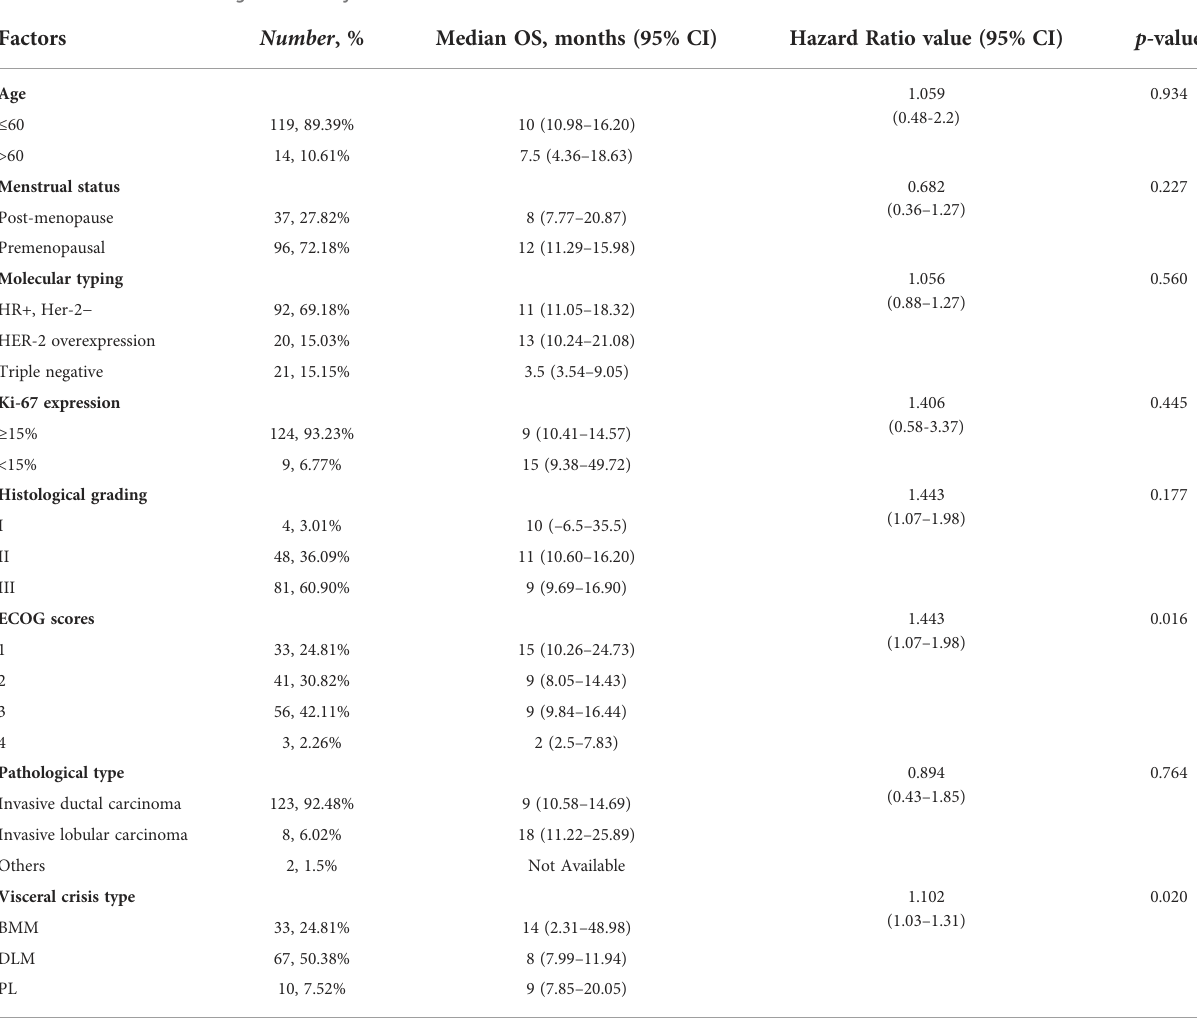
FIGURE 10 OS of patients with different ECOG scores.